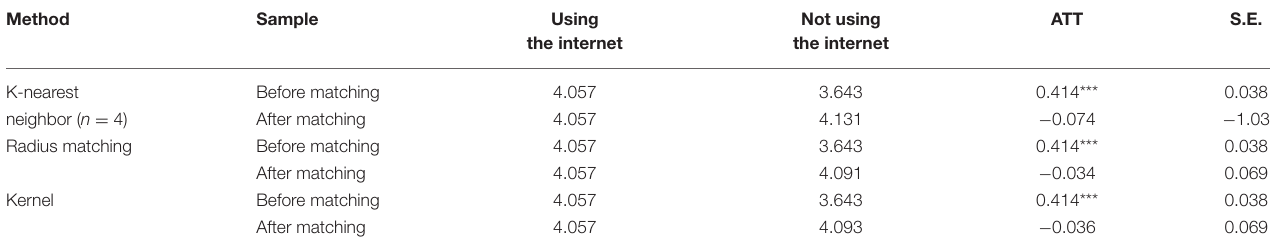
TABLE 8 | Results of the PSM and Chinese general social survey (CGSS)